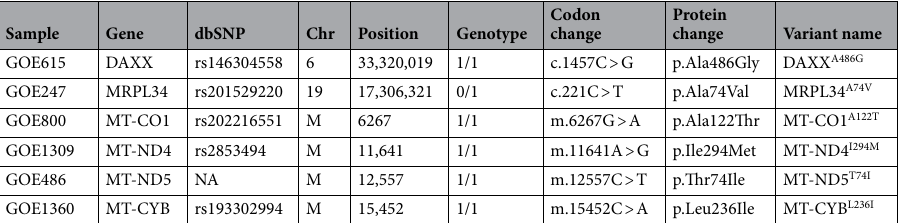
Table 4. Overview of mutations detected in the scRNA-seq and bulk